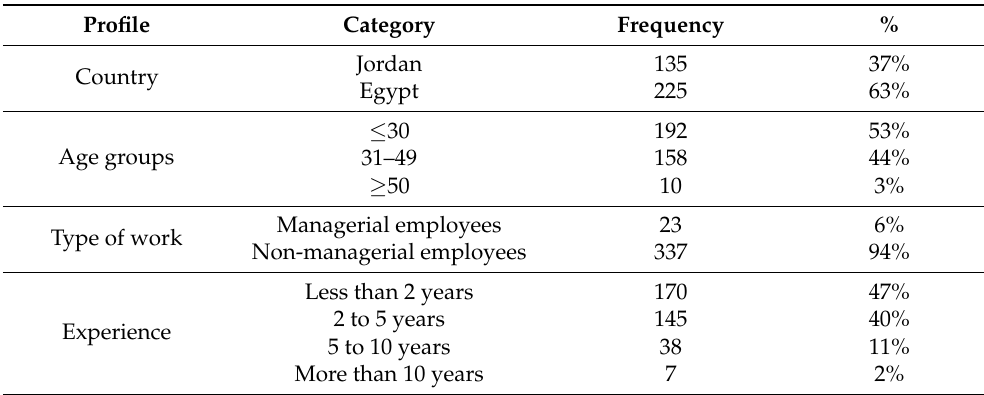
Table 1. Sociodemographic profile of the